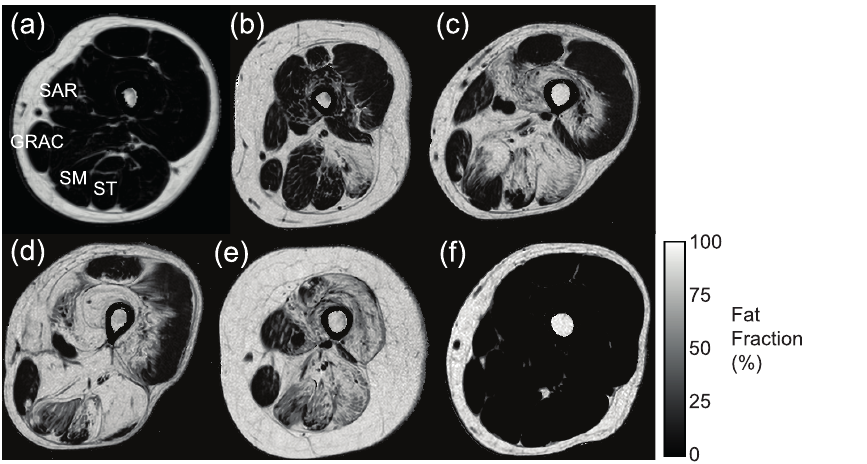
Figure 4. Quantitative fat images of the thigh in LGMD2I patients with increasing stages of severity and increasing fat fraction (a– e), and in a control subject (f). In (a) this is almost normal, however in (e) only sparing of gracilis (fat fraction 13.7%) and sartorius (24.0%) is seen. (SM= semimembranosus, ST= semitendinosus, GRAC= gracilis, SAR= sartorius).